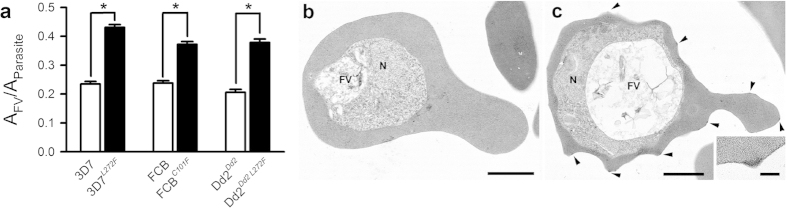
Morphological comparisons of parasites with mutations in pfcrt compared with their parental controls.(a) Parasites were synchronized by sorbitol lysis and areas of FVs and parasites (approximately 38 h post-invasion) were measured and expressed as ratios (AFV/AParasite). 3D7, FCB and Dd2Dd2 (open bars; n = 72, 31 and 42, respectively) and 3D7L272F, FCBC101F and Dd2Dd2 L272F (closed bars; n = 84, 58 and 88, respectively) parasites were analyzed and significant enlargement of the FV was confirmed in 3D7L272F, FCBC101F and Dd2Dd2 L272F parasites relative to 3D7, FCB and Dd2Dd2, respectively (*p < 0.0001: two-tailed, unpaired, Student’s t-test). (b,c) Transmission electron micrographs of 3D7 and 3D7L272F parasites, respectively, showing the food vacuole (FV) and nucleus (N). Note the enlarged electron lucent FV in 3D7L272F (suggesting changes in the process of hemoglobin degradation and formation of hemozoin crystals). RBCs infected with 3D7L272F displayed approximately 7.5-fold more knobs (arrowheads) on the host surface than 3D7-infected RBCs, although this is likely due to sub-population selection rather than a direct link to the mutation in pfcrt. (insert) Detail of a knob. Bars represent 1 μm (b,c) and 100 nm (insert).